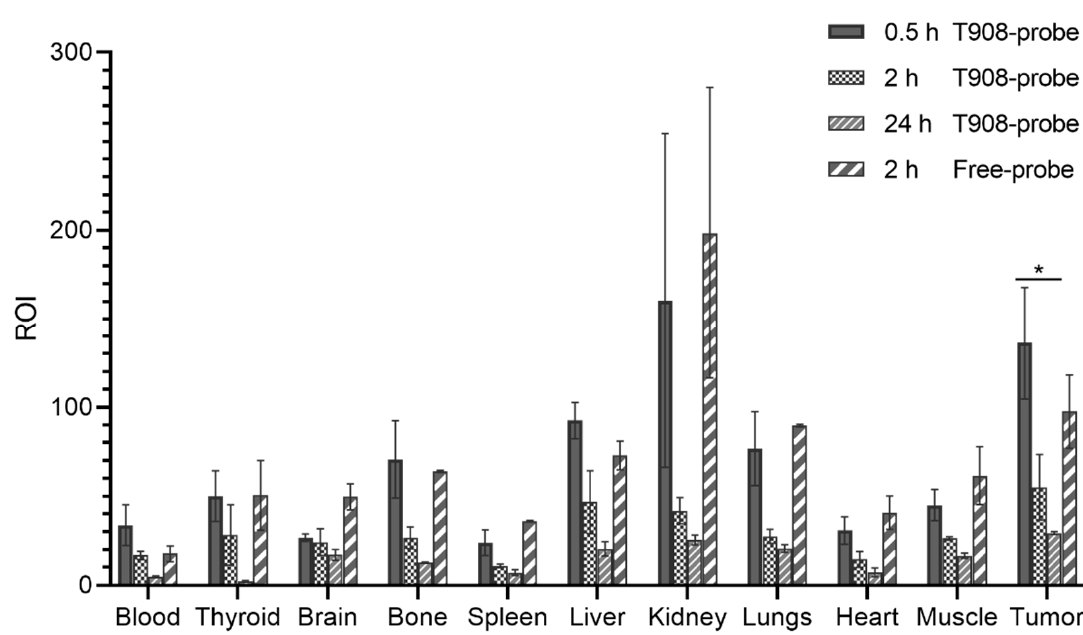
Figure 7. Biodistribution results for T908-probe at 0.5, 2, and 24 h post-injection in A20 tumor-bearing BALB/c mice. Control free-probe at 2 h post-injection. * p = 0.02 (Student’s t -test).